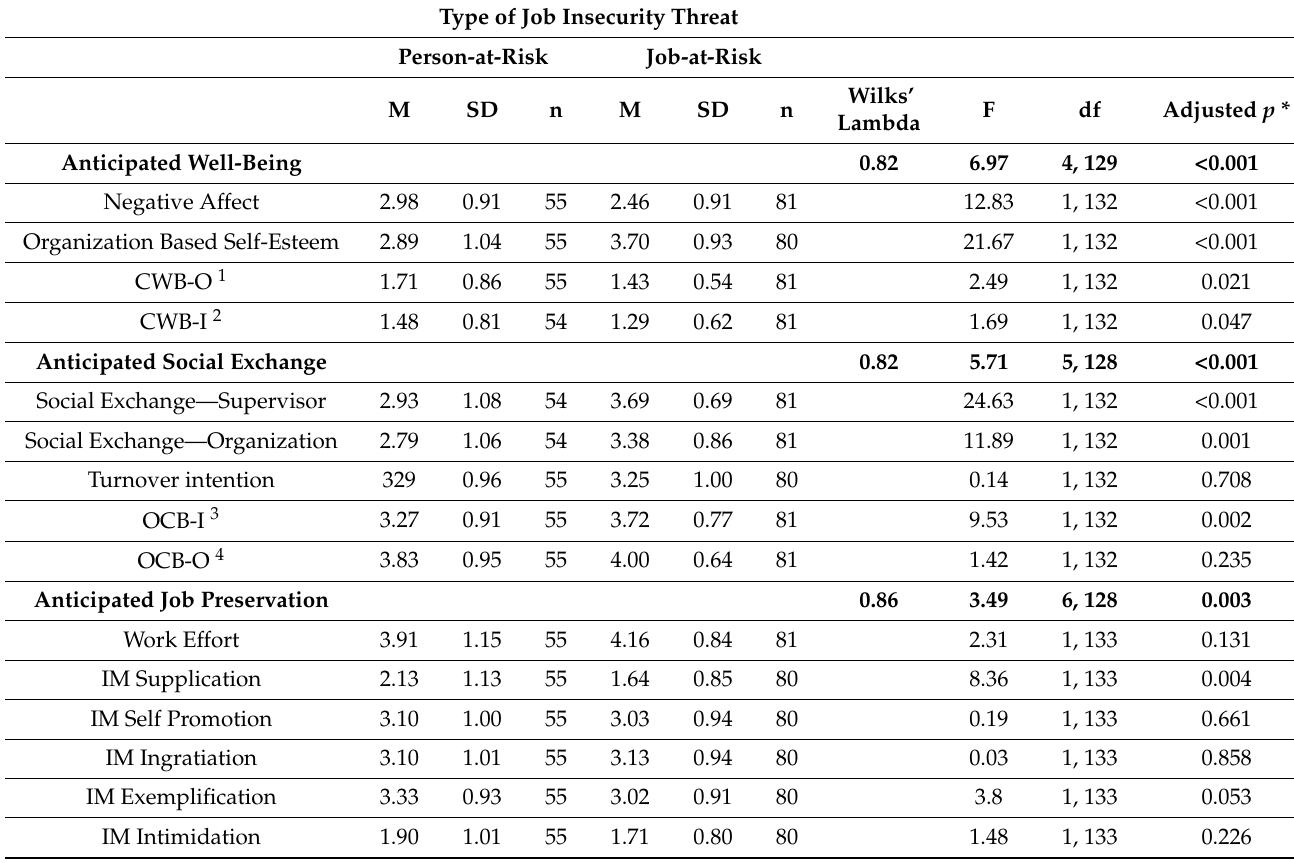
Table 1. Results of